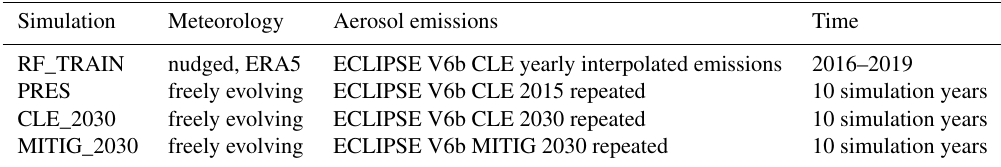
Table 2. Experiment